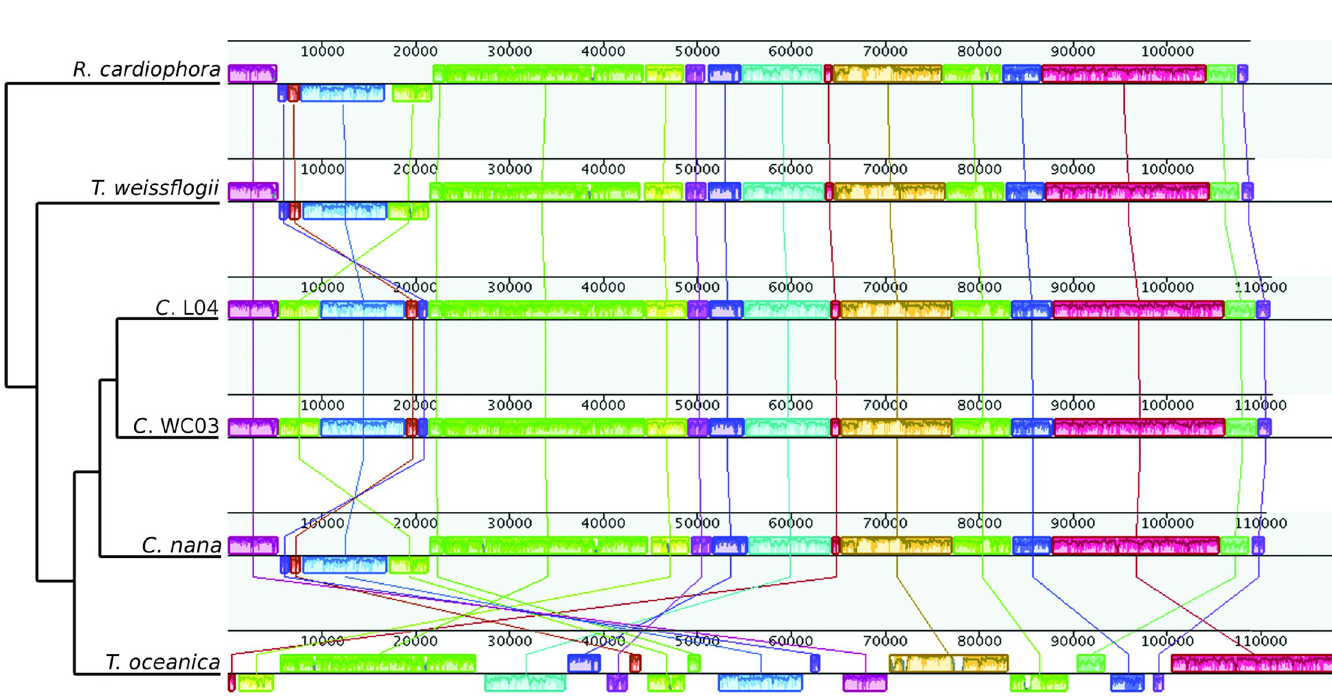
Fig 4. Gene order comparison of plastid genomes of six thalassiosiroid diatoms with one copy of the inverted repeat removed prior to analysis. Alignment and resulting locally collinear blocks (LCBs) were generated using MAUVE. Relationships between taxa displayed as a cladogram to the left of the diagram are based on Fig 2.